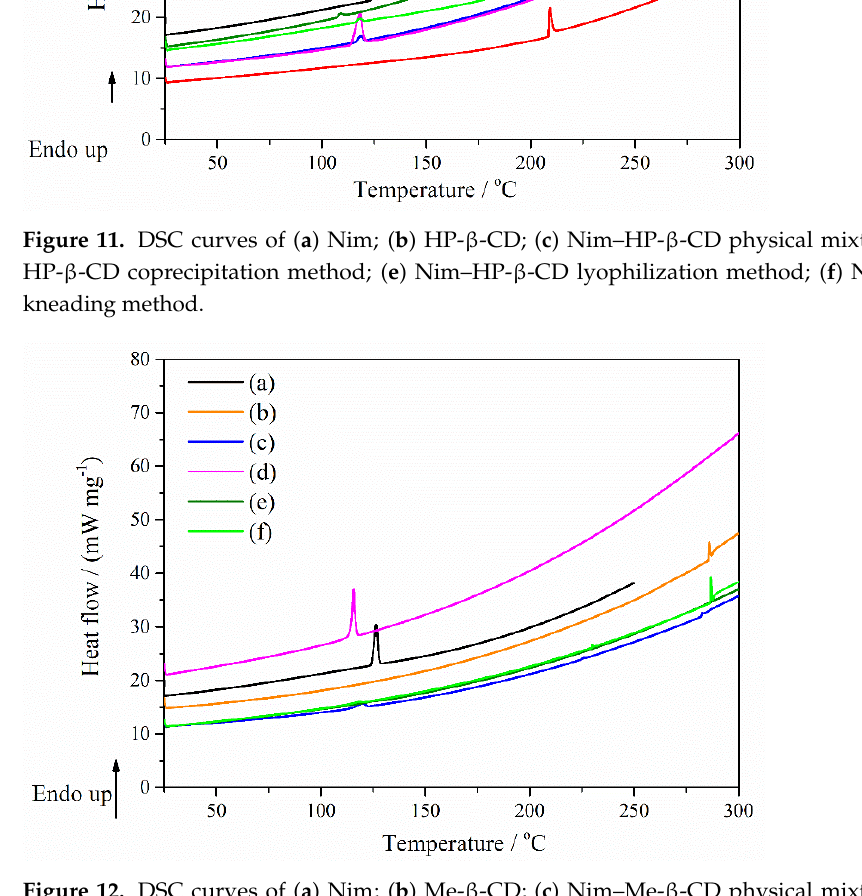
Table 3. Thermodynamic parameters for process of samples from DSC measurements.